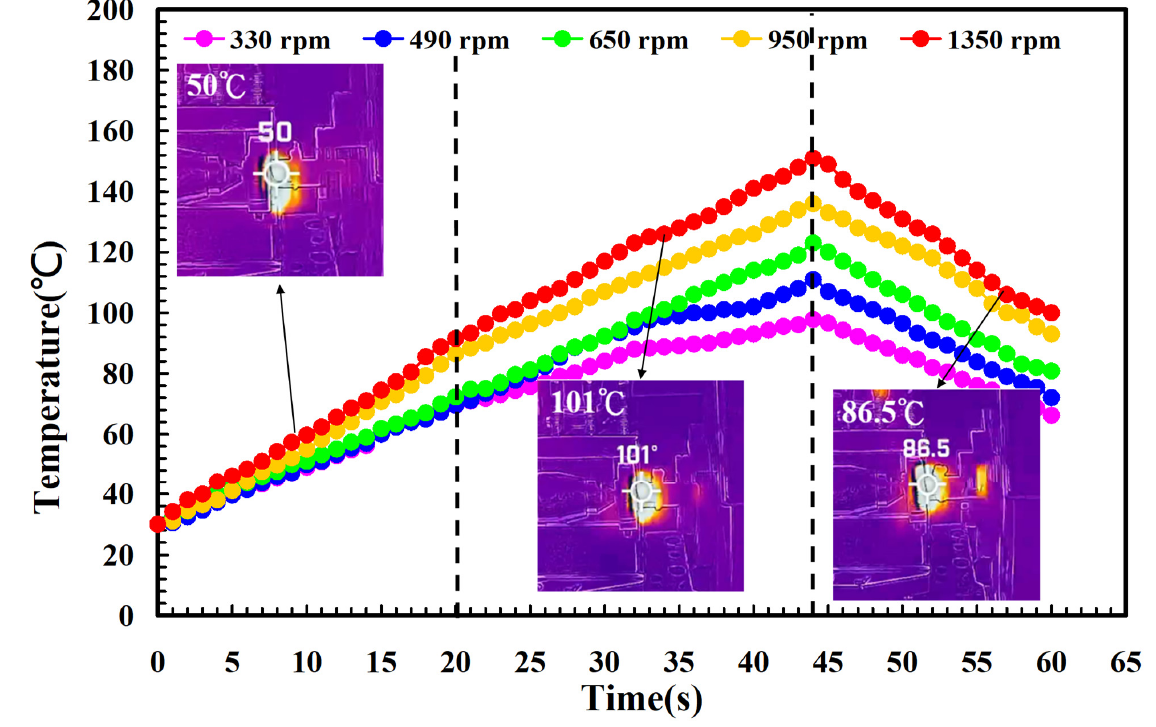
Figure 8. The relationship between weld-joint temperature and FW time for the PLA and PLA filled with GF rods at five different rotational speeds.